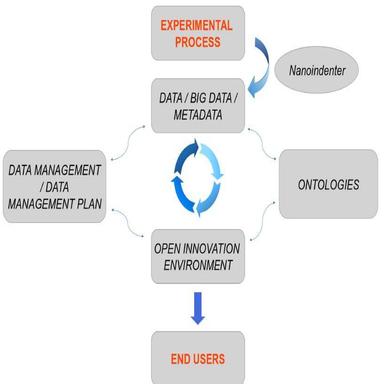
Interaction among Data, Ontologies, DMP and OIE – specific example for nanoindentation testing as a main adopted characterization method: starting from an experimental process (nanoindentation) data is created through measurements; this data and the corresponding metadata are recorded with the usage of a DMP and organized using an ontology; finally a user can retrieve information for this data from an Open Innovation Environment in which the connection between raw data and processed data (e.g. elastic modu